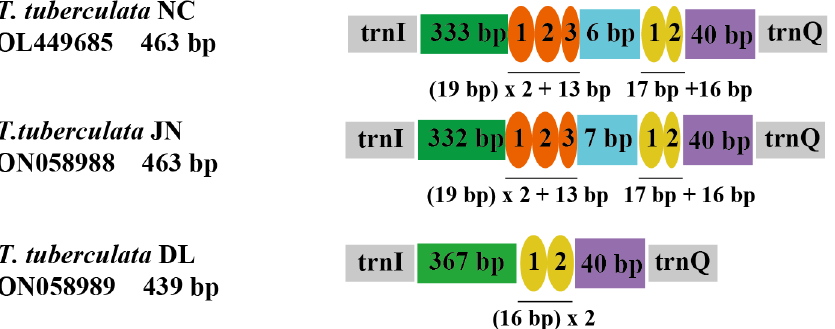
Figure 3. Organizations of the repeat regions in the A + T rich region of the T. tuberculata NC, T. tuberculata JN, and T. tuberculata DL. Ovals with different colors indicate tandem repeat sequences. The colored box shows the non-repeat region.